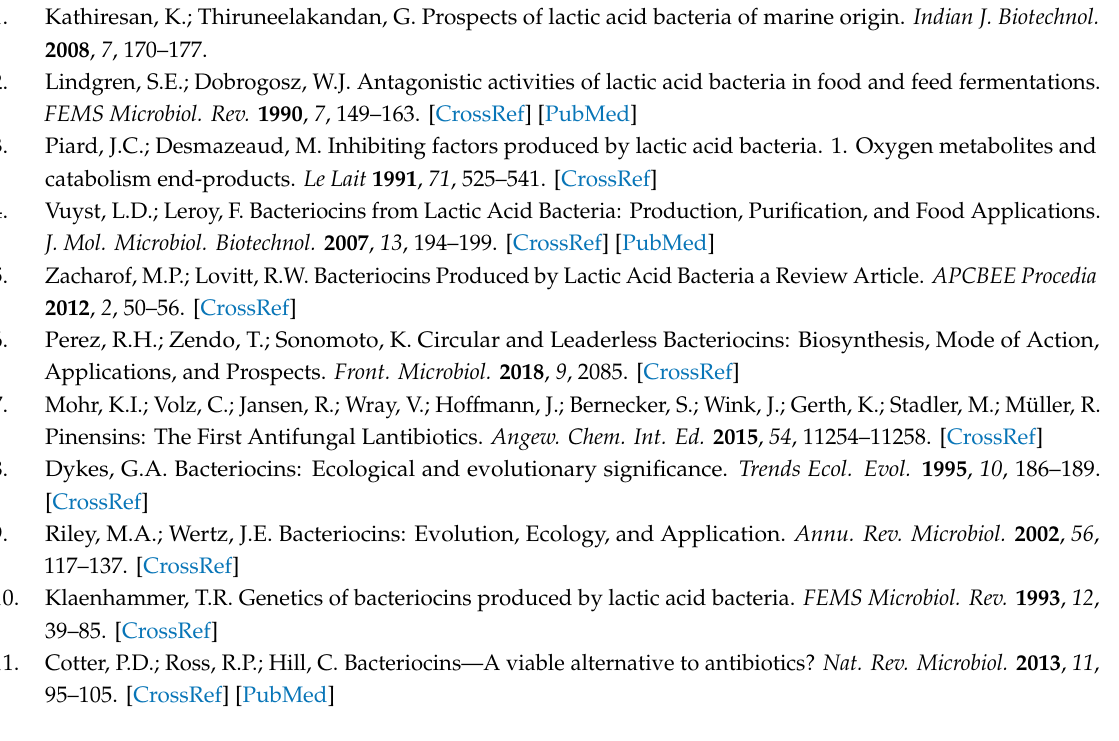
Figure S1: 16S rDNA maximum likelihood phylogenic tree, Table S1: Characterized bacteriocins in Carnobacterium spp.; Table S2: Carnobacterium spp. strains and related genomes used for genome mining; Table S3: Inhibitory activity of Carnobacterium cultures and supernatants in the presence or not of